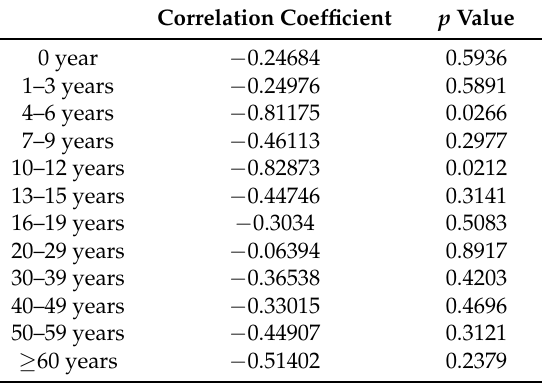
Table 4. Correlation between cumulative incidence of influenza and vaccination coverage